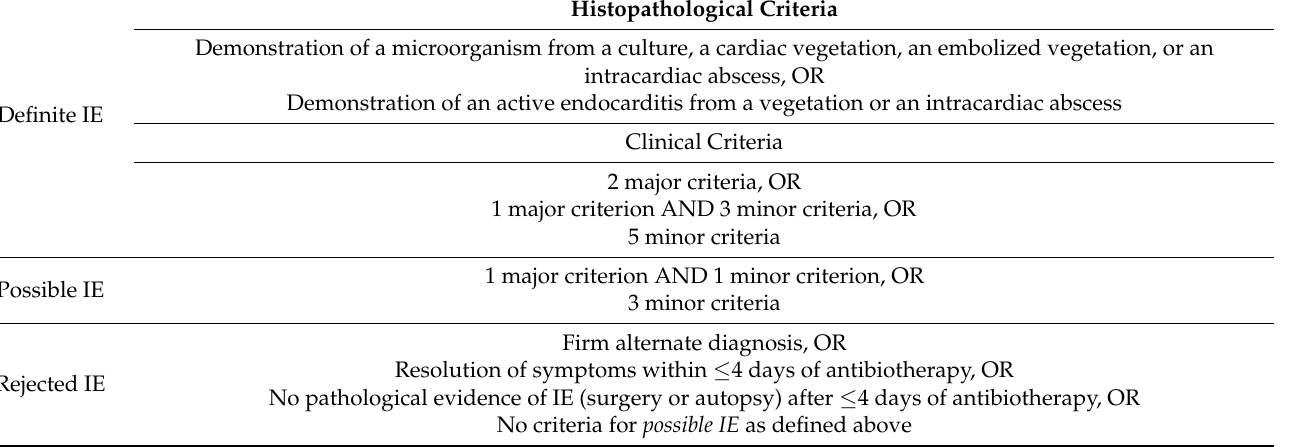
Table 2. Definition of infective endocarditis according to the modified Duke criteria. Adapted from Habib et al. [12].